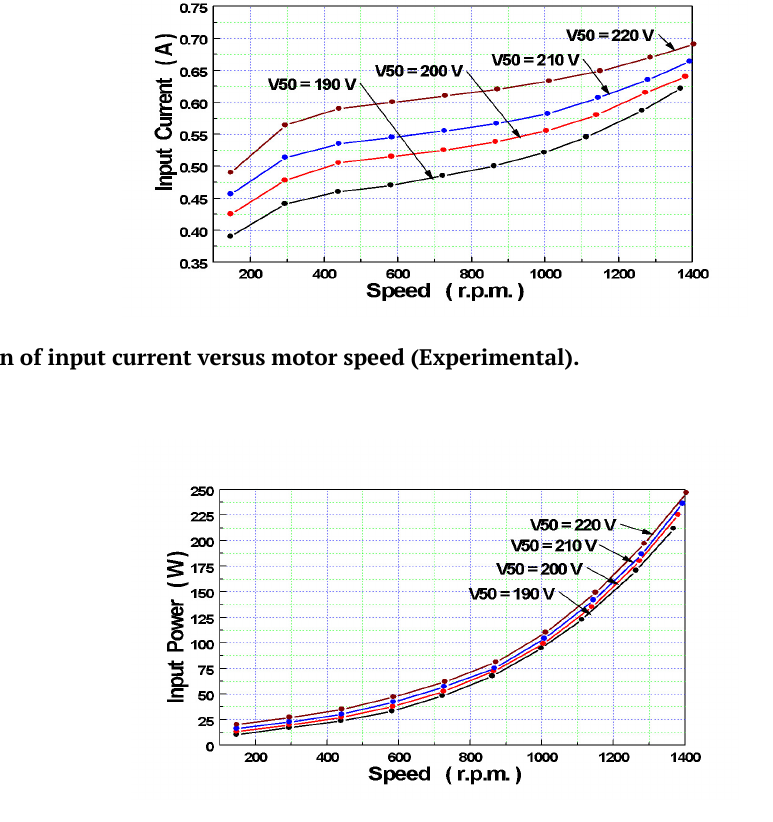
Fig. 13. Variation of input power with motor speed (Experimental).